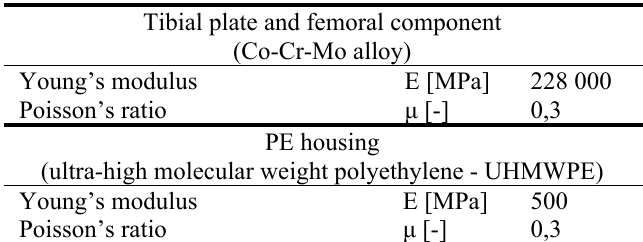
Fig.7. Fixed PE housing; Position 5